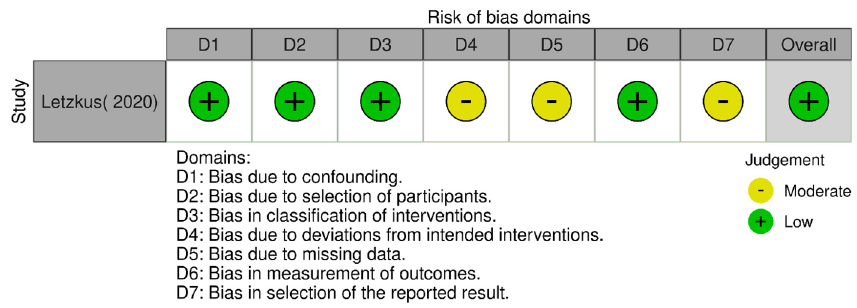
Figure A1. Risk of Bias in Non-randomized Studies of Interventions (ROBINS-I). Table A1. Quality Assessment of Cohort study using Newcastle-Ottawa Scale (* stars